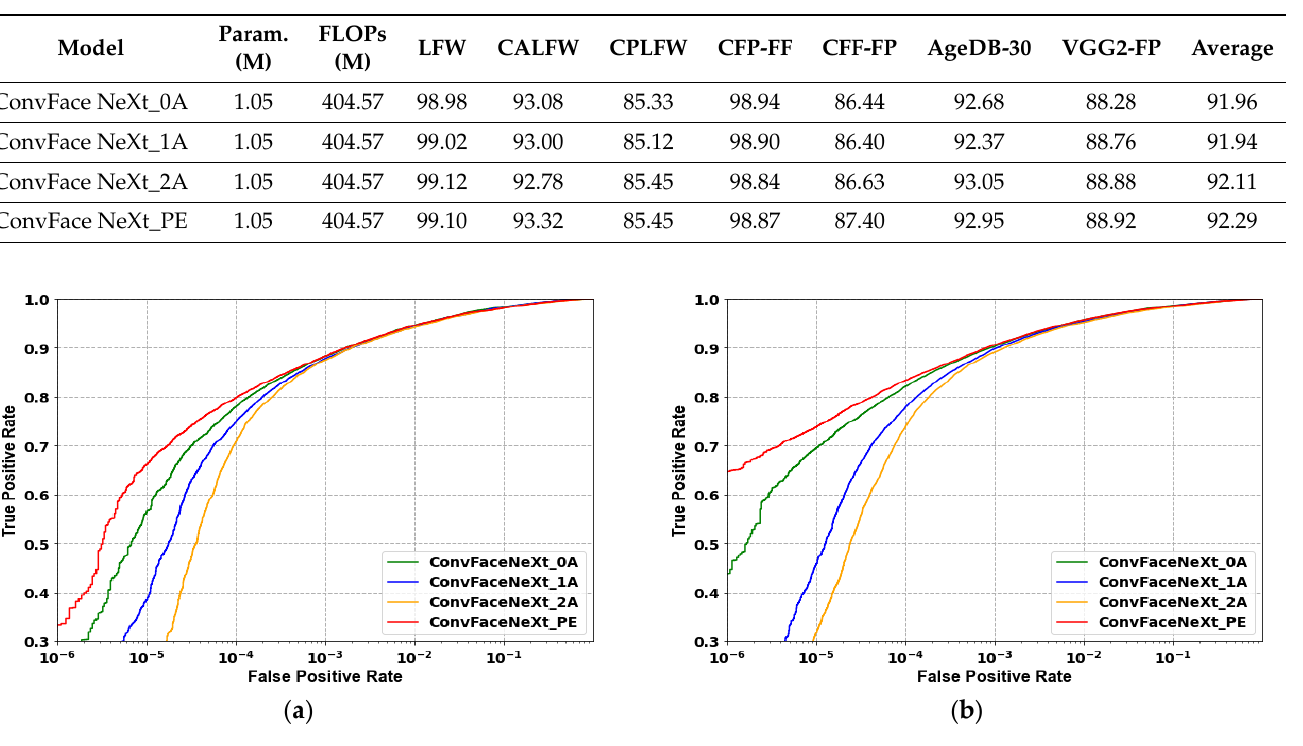
Figure 4. ROC curves of 1:1 verification for different linking strategies. ( a ) IJB-B dataset. ( b ) IJB- C dataset. Table 5. Verification accuracy of different linking strategies on IJB-B and IJB-C